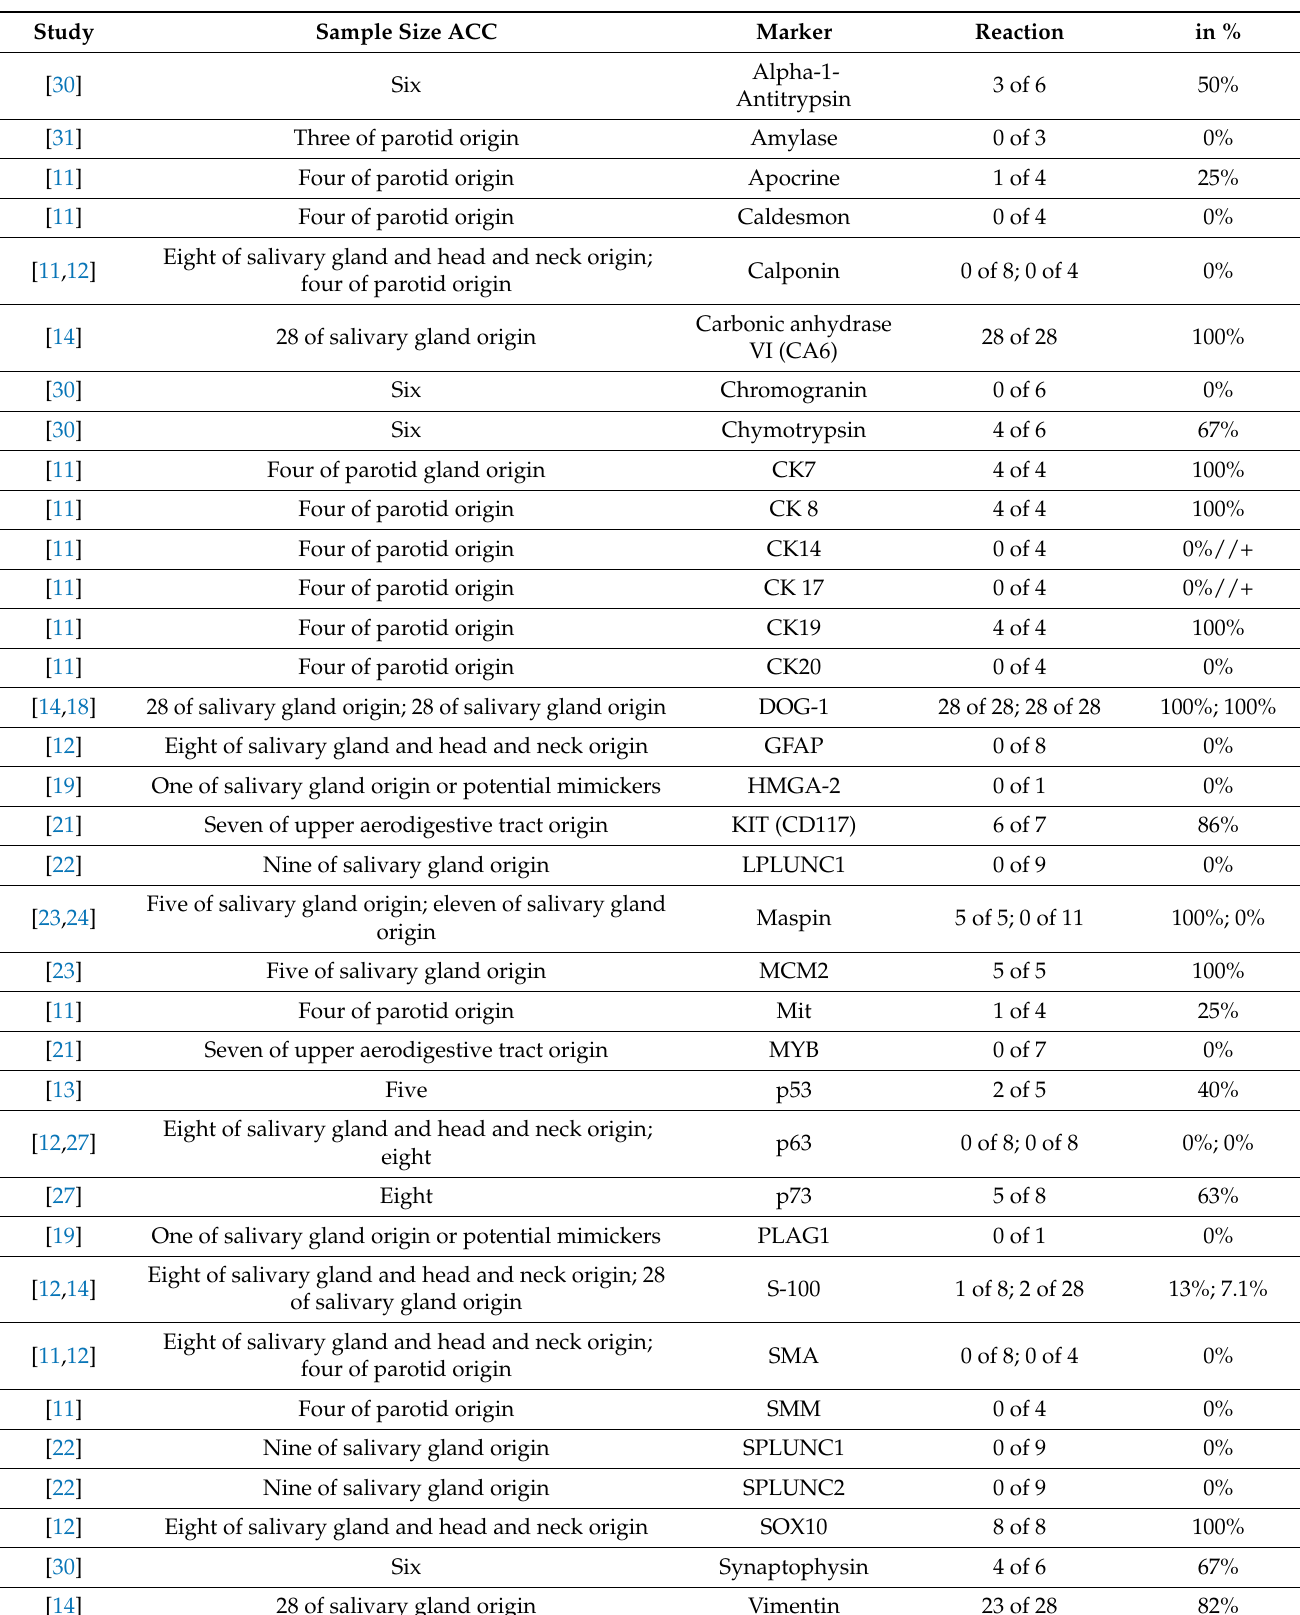
Table 3. Analysis of results for acinic cell carcinoma patient